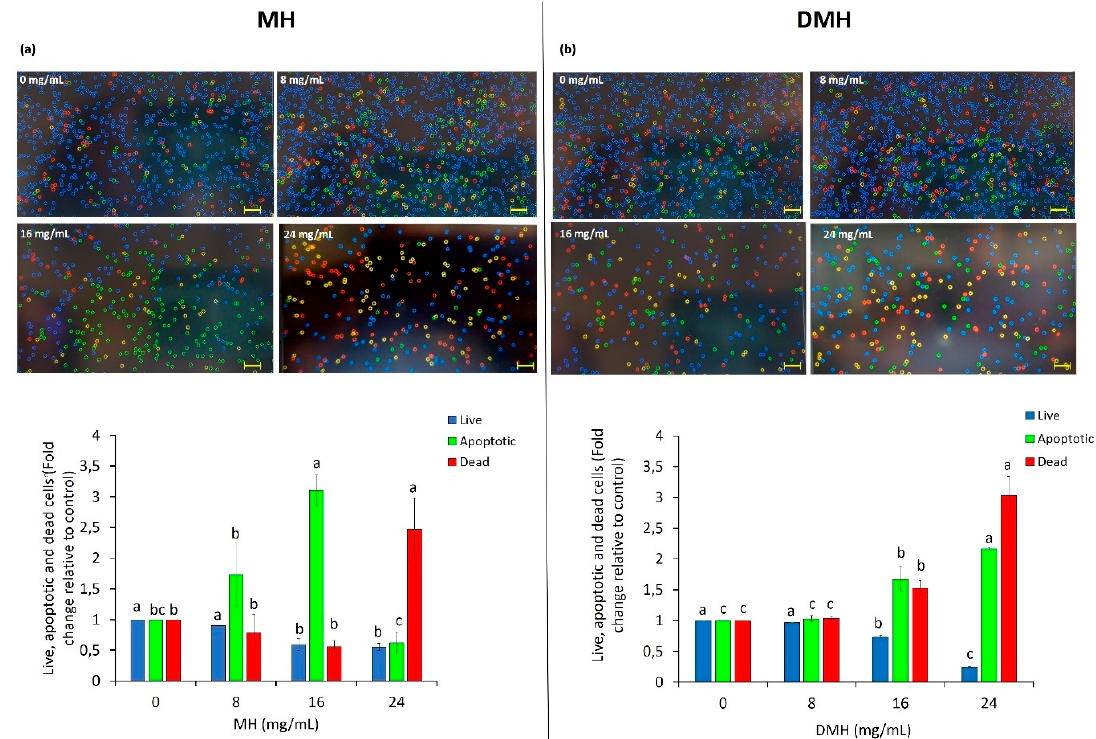
Figure 5. Apoptosis induction by MH ( a ) and DMH ( b ) in HCT-116 cells. The cells were treated with di ff erent concentration (0, 8, 16 and 24 mg / mL) of MH or DMH for 48 h. Live, apoptotic and dead cells in HCT-116 were determined by Annexin V Alexa Fluor ® 488 and PI staining was done with Tali ® Image-Based Cytometer. The images are representative of the e ff ect of MH and DMH with or without treatment: blue corresponds to live cells, green to apoptotic cells and the red or yellow color to dead cells. Values are expressed as the mean of three independent experiment ± SD. The di ff erent superscript letters (a–c) in each bar indicate significant di ff erence ( p < 0.05). Scale bar = 50 µ